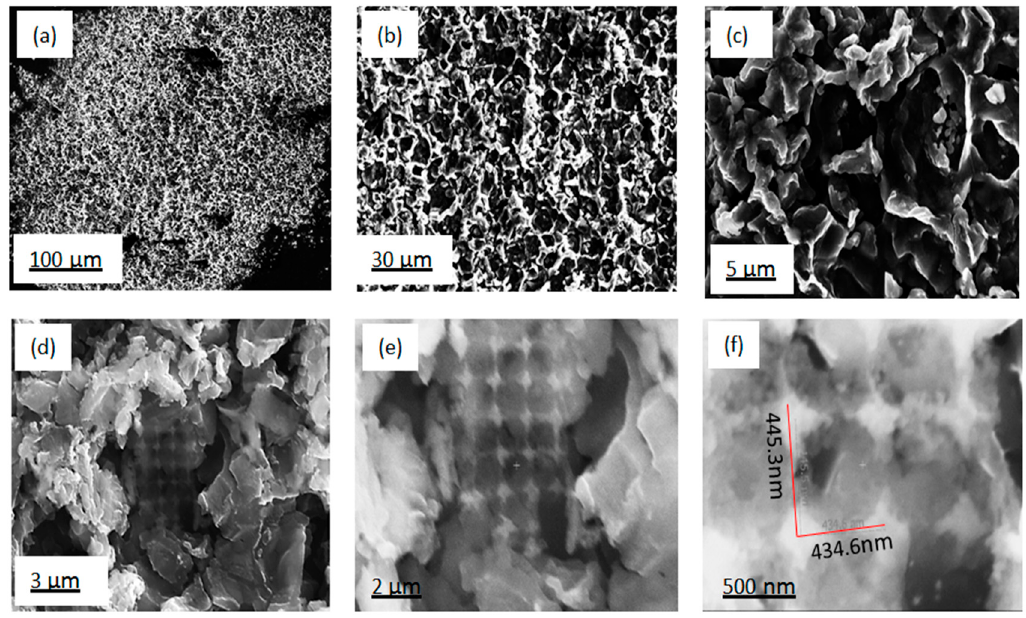
Figure 6. SEM images of the as-etched Si nanoflakes: ( a) very low magnification surface view, ( b ) low magnification surface view, ( c ) large magnification surface view, ( d ) specific highly ordered feature, ( e ) large magnification of a specific highly ordered feature, and ( f ) nanoporous nature of a specific highly ordered feature.